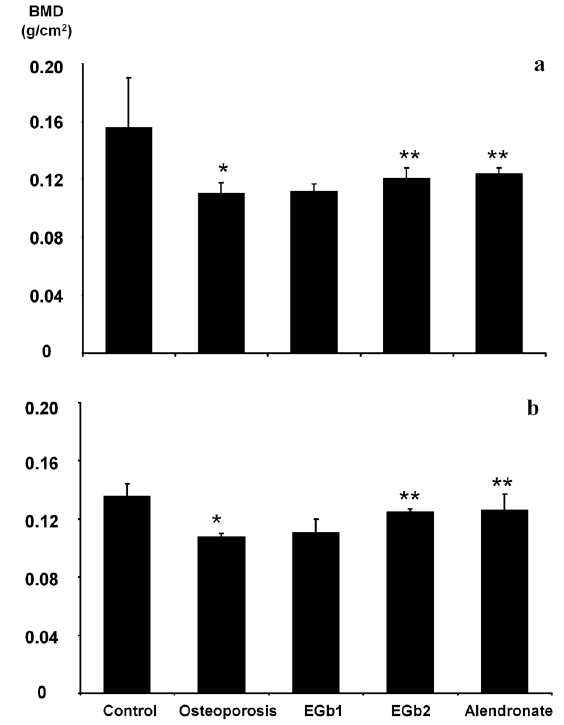
Figure 2 - Bone mineral density (BMD) using dual-energy x-ray absorptiometry. a - 20 days of treatment. b - 30 days of treatment. a - *p<0.05 when the control group was compared to the osteoporosis group (Mann- Whitney test). a -**p<0.05 when all groups, except the control, were compared to the osteoporosis group (Tukey test). b - *p<0.05 when the control group was compared to the osteoporosis group (Student`s t-test). b **p<0.05 when all groups, except the control, were compared to the osteoporosis group (Dunnett T3